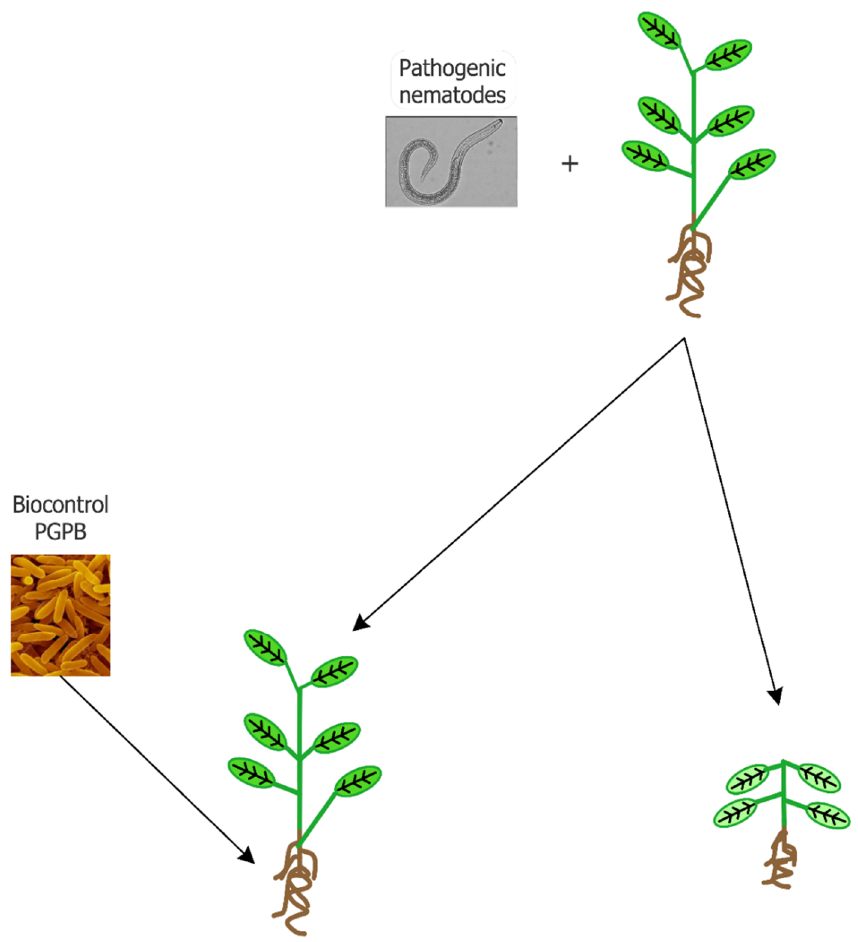
Figure 1. Schematic representation of the use of biocontrol plant growth-promoting bacteria (PGPB) to prevent plant damage by plant-parasitic phytopathogenic nematodes.